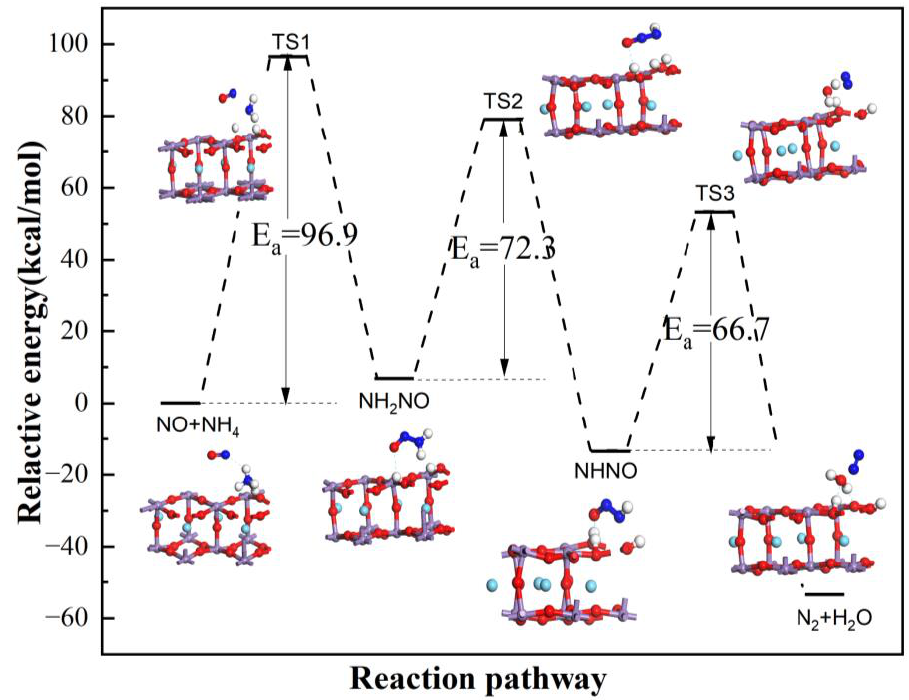
Figure 16. The NH 4+ reaction process in the Figure 13c configuration over the catalyst.